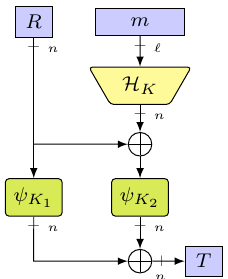
and ψ are two independent keyed functions, H K 2 1